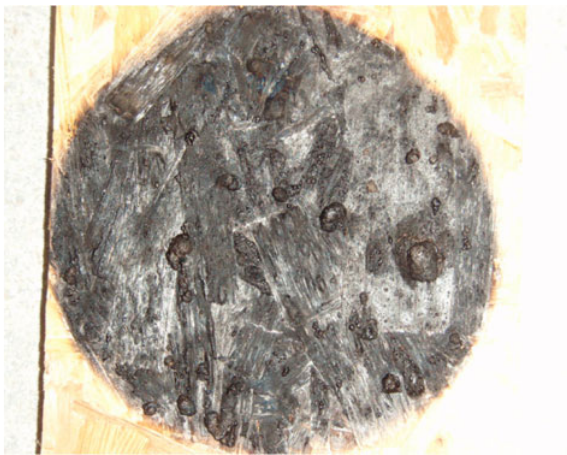
Fig. 4. Flame retardant residues on OSB